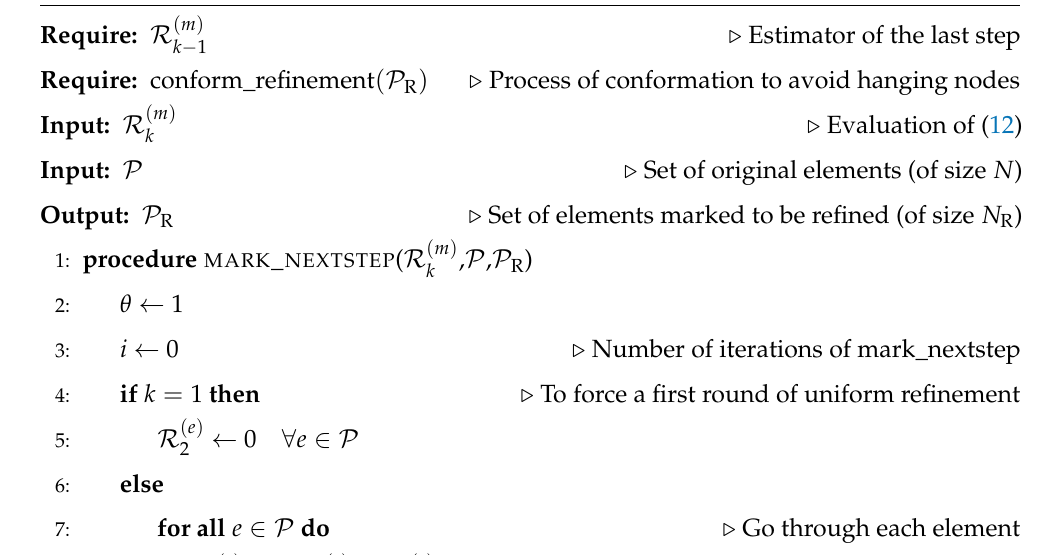
Algorithm 1 Marking strategy using the next-step estimator inspired by